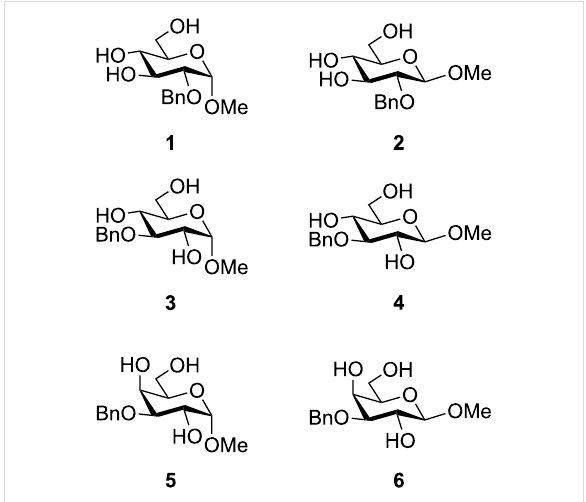
Figure 1: Monobenzylated methyl α - and β -D-gluco- and galactopyra- noside acceptors 1 – 6 .